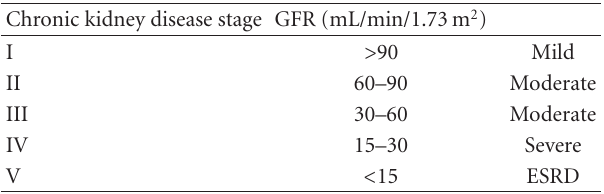
Table 1: Stages of CKD as related to the GFR of the patient. Chronic kidney disease stage GFR (mL/min/1.73m 2